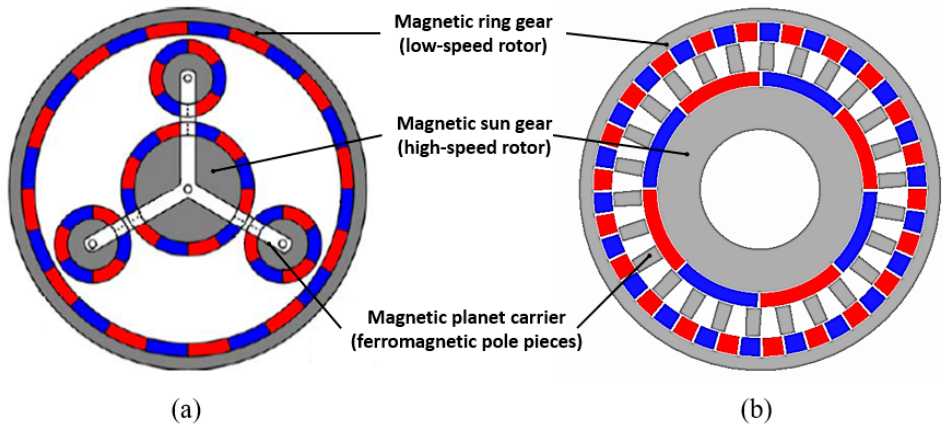
Figure 8. Magnetic gear: ( a ) Planetary type; ( b ) With field modulation.